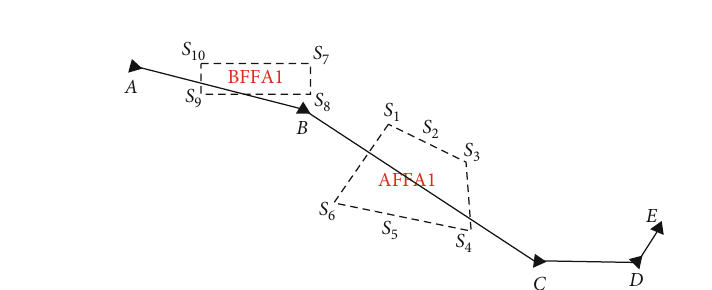
Figure 9: Initial boundary of hazardous weather on the Guiyang – Guangzhou route in